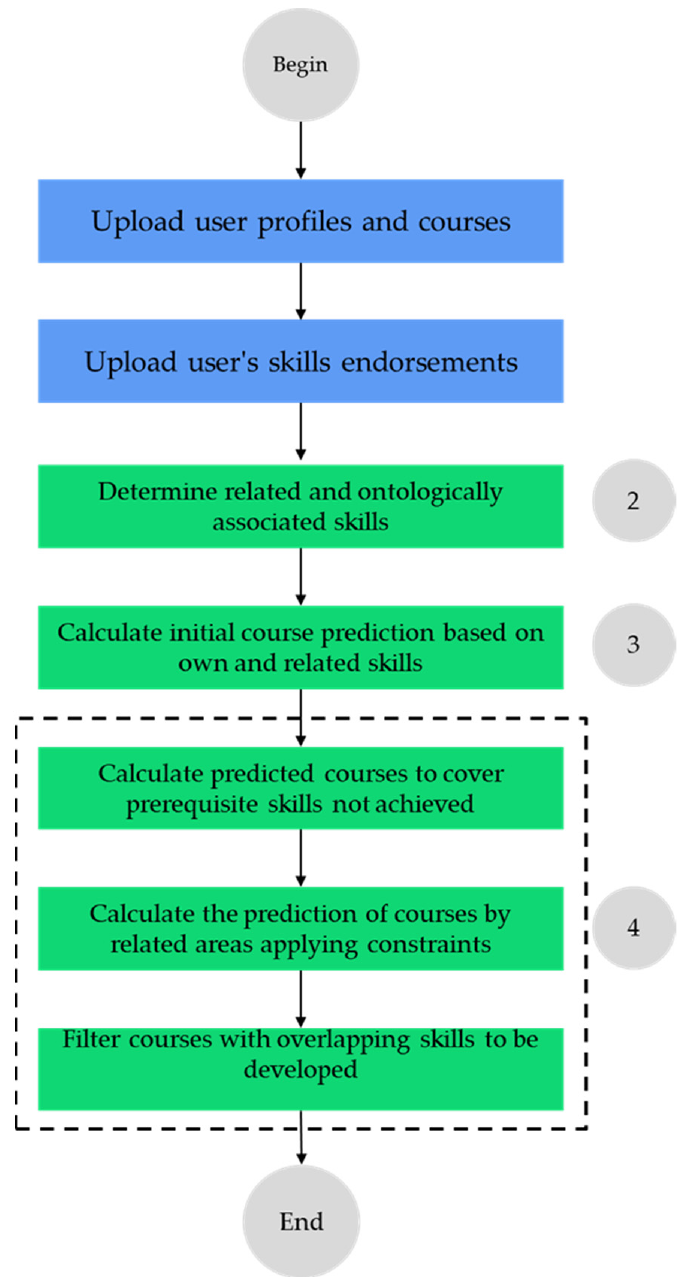
Figure 2. General recommendation algorithm.